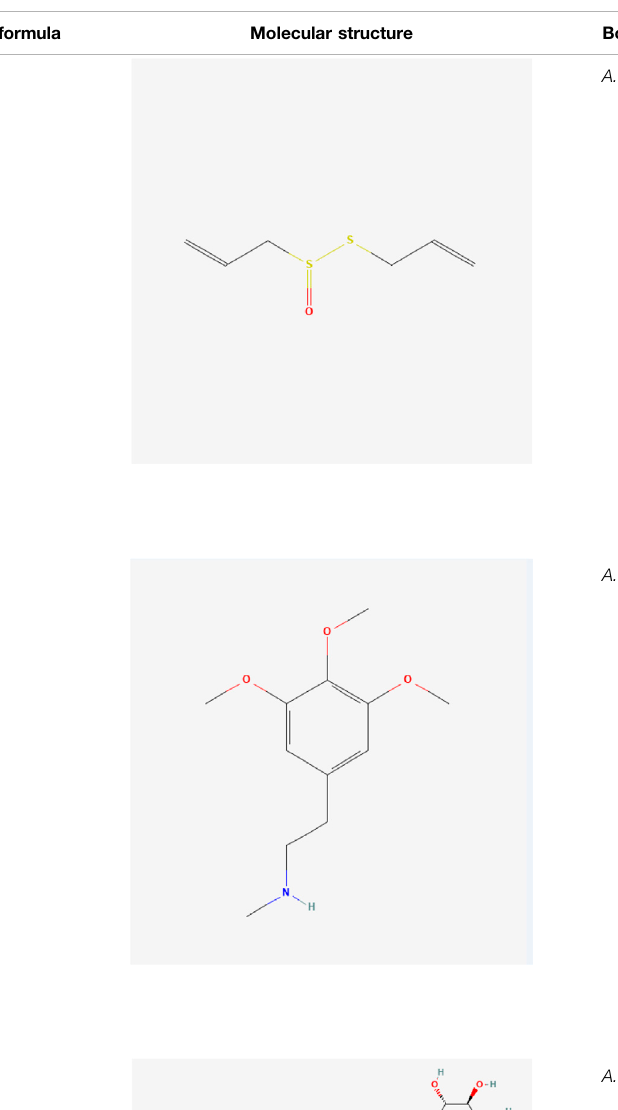
TABLE 1 | Chemical compound information of